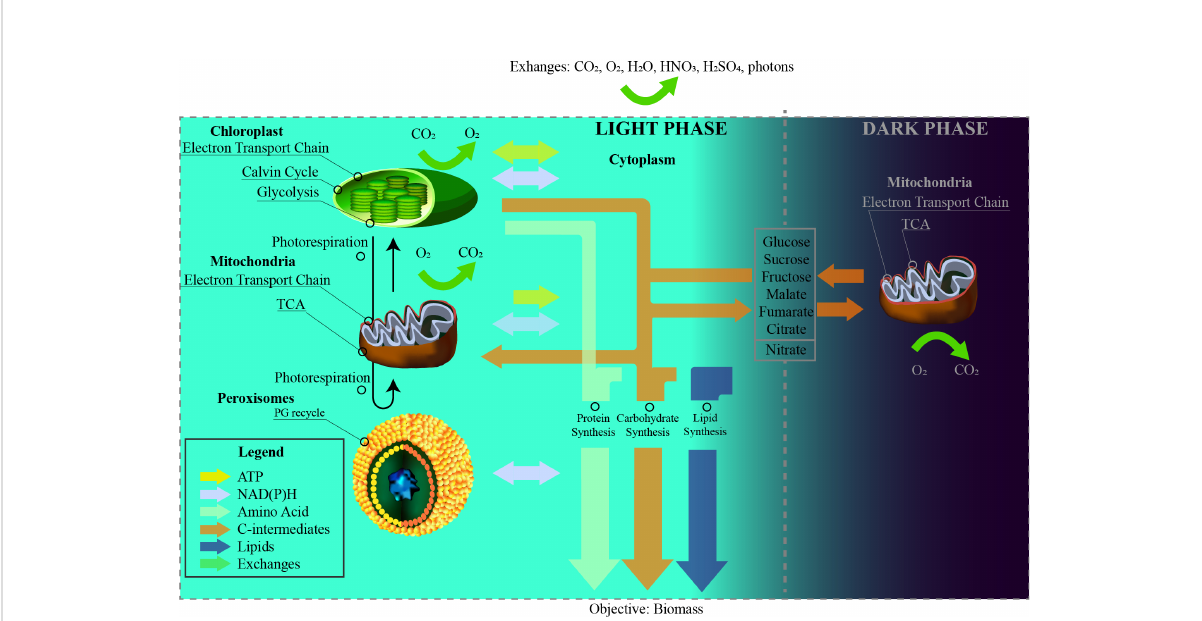
FIGURE 2 Structure of the diel model presented. Four compartments (chloroplast, mitochondria, peroxisomes, and cytoplasm) and the two phases of the day (light and dark) are considered with exchange reactions including metabolites diffused through leaves (CO 2 , O 2 , H 2 O, light photons) and through the roots (HNO 3 and H 2 SO 4 ). PG represents